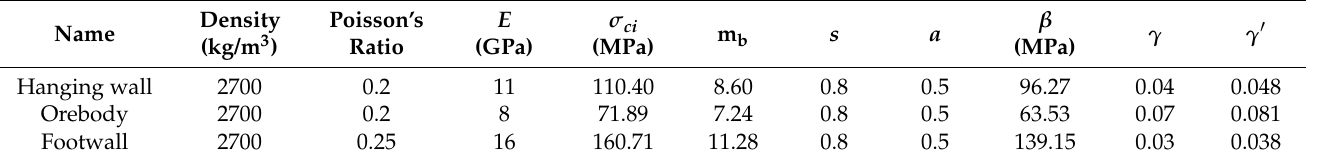
Table 2. The physical and mechanical parameters of rock masses ( E is the Young’s modulus; σ ci is the unconfined compressive strength; m b , s , and a are the rock mass material constants of H–B empirical strength criterion; β , γ , and γ (cid:48) are residual strength parameters.).